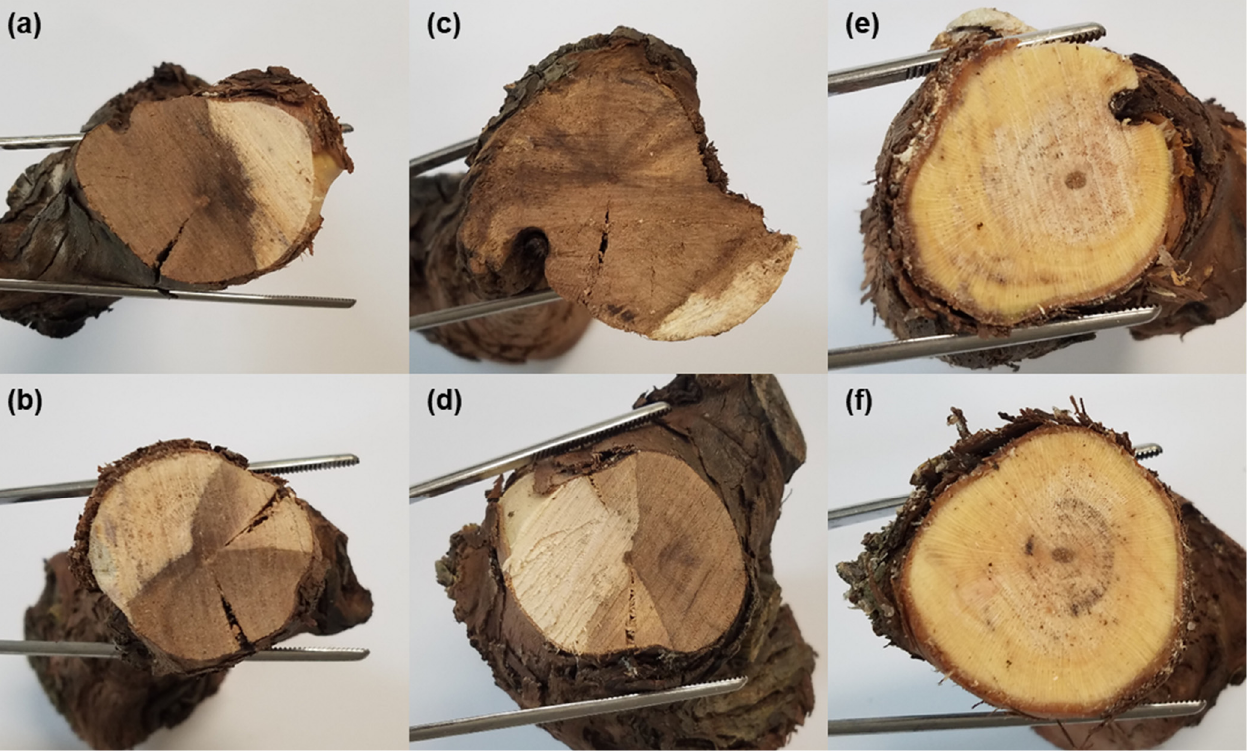
Figure 4. Examination of cross sections. ( a , b ) Cordon dieback but no foliar symptoms; ( c , d ) cordon dieback and foliar symptoms; ( e , f ) symptomless.